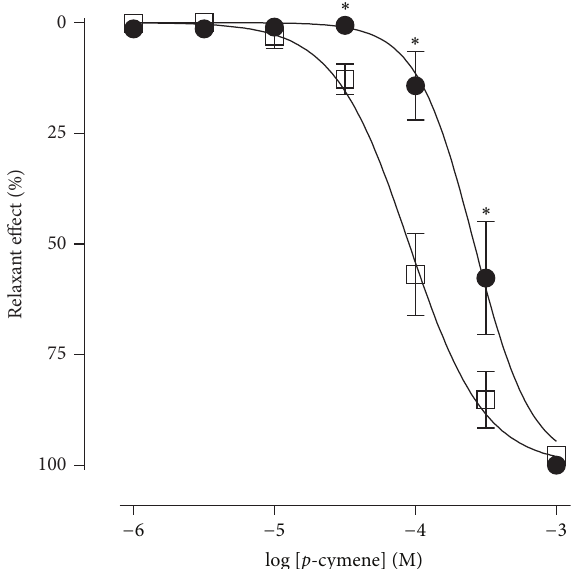
Figure 4: Relaxant effect of p -cymene on the isolated rat aortic rings without endothelium, contracted by phenylephrine, in the absence ( ◻ ) and presence of CsCl 5 mM ( e ). ∗ 𝑃 < 0.05 (unpaired 𝑡 -test: absence × presence of